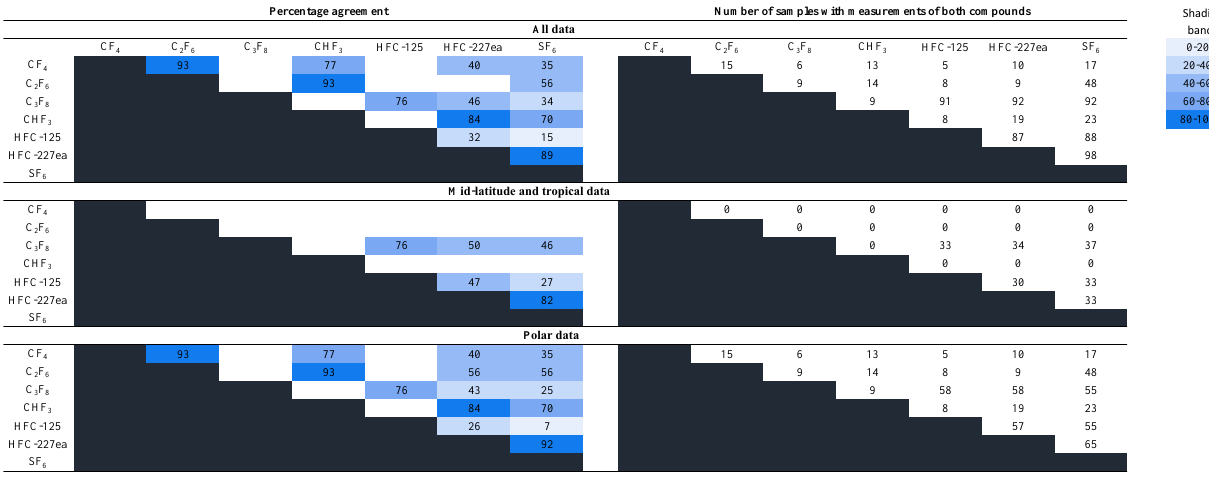
Figure 3. Vertical profiles of mean ages derived from all compounds used in this study. Panels (b) and (c) show the same data as in (a) but split into polar (b) and mid-latitude and tropical (c) flights only (see Table 2 for campaign details). Colours represent different age tracers (see inset legend) and remain the same across all panels. Table 4. Percentage of samples for which the mean age derived from two tracers agreed within the uncertainties ∗ .